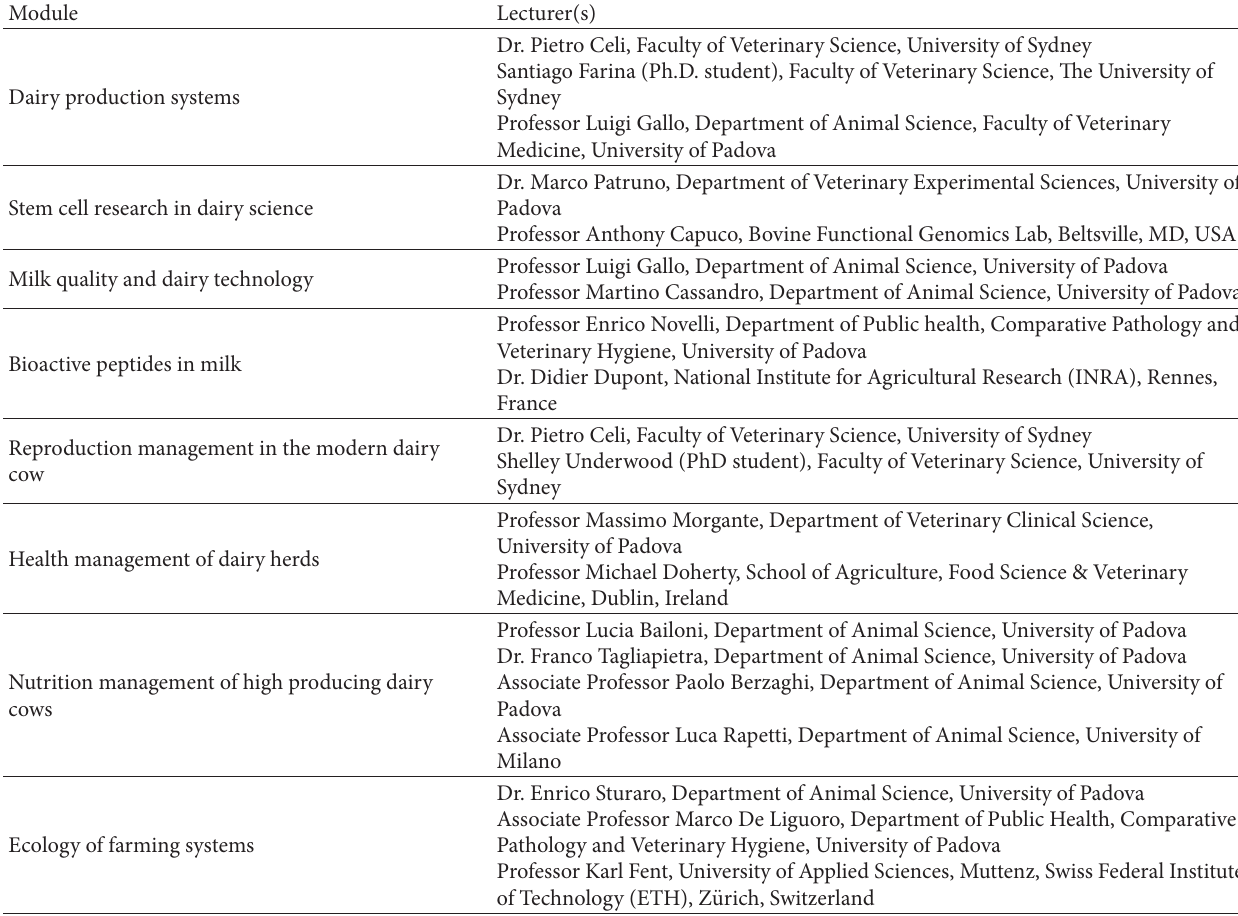
Table 1: Modules offered during the Ph.D. summer school in dairy